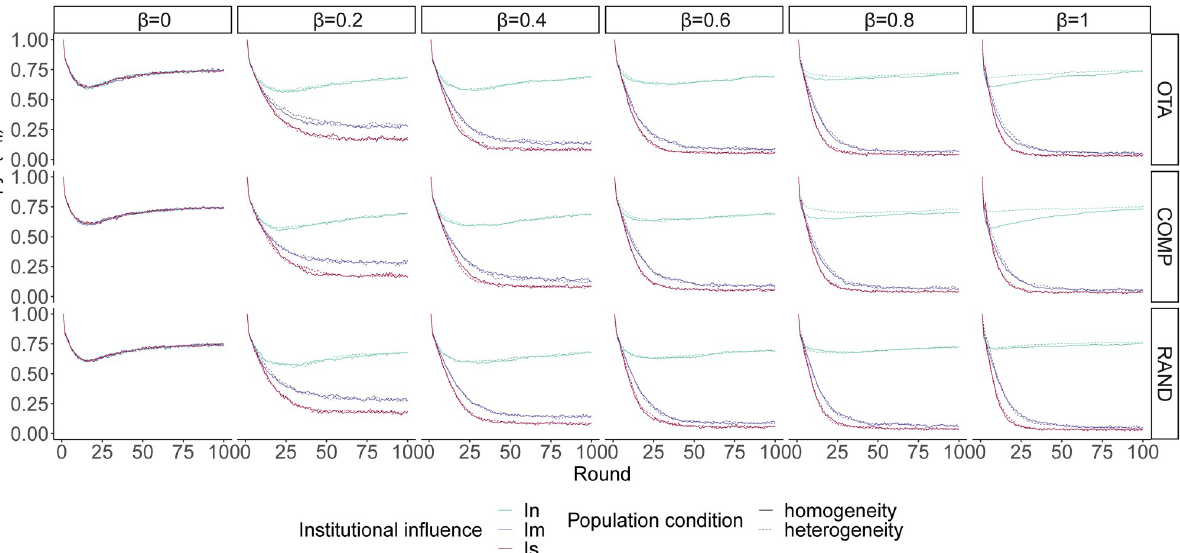
PLOS ONE | https://doi.org/10.1371/journal.pone.0257525 September 28,